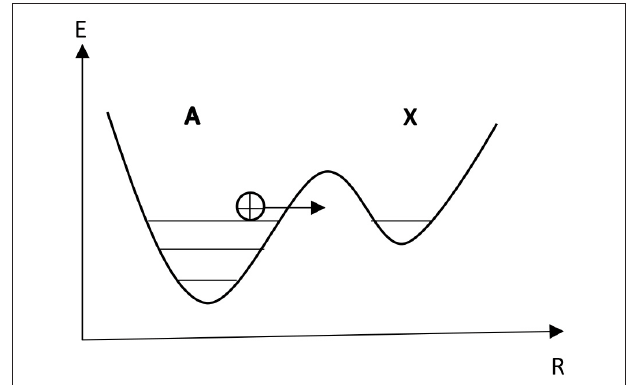
FIGURE 2 | The double-well potential for a single proton